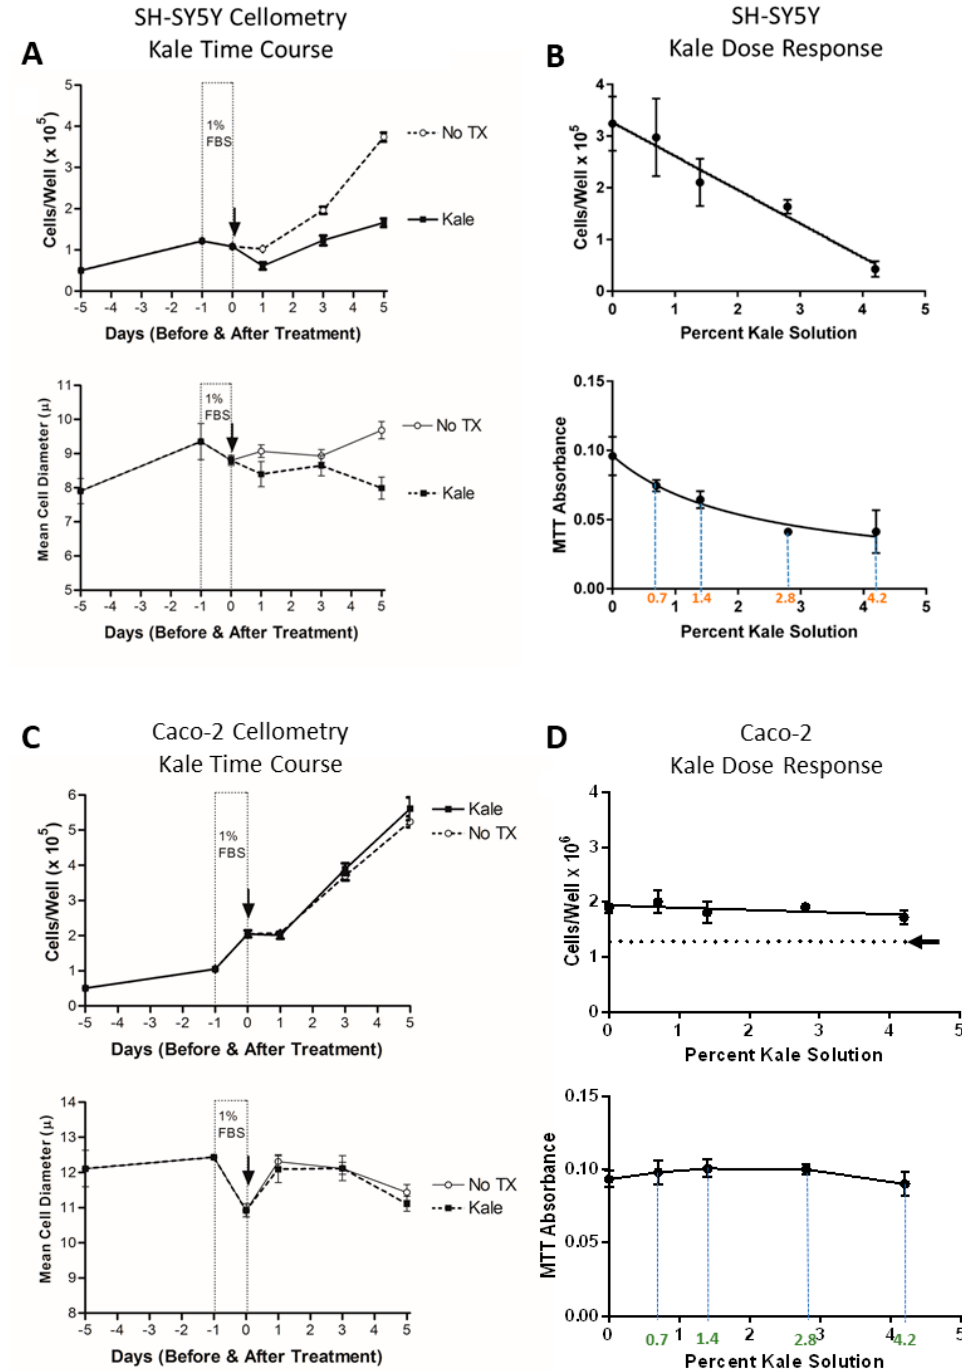
Figure 5. Kale juice time course and dose response curves for monocultures of SH-SY5Y ( A , B ) and Caco-2Bbe1 ( C , D ), comparing total cellometry counts, mean cell diameters, and MTT metabolism values. The same analytical methods were used as in Figure 4 except now in monocultures. After plating and growing the cells in 24-well plates for four days, they were switched to 1% FBS media for 24 h, and then given complete media replacements the next day with up to either 4.2% kale juice or 4.2% PBS and monitored over five more days: A-upper panel, SH-SY5Y cell counts; A-lower panel, SH-SY5Y mean cell diameters; C-upper panel, Caco-2Bbe1 cell counts, C-lower panel, Caco-2Bbe1 mean cell diameters. B-upper panel, SH-SY5Y cell counts; B-lower panel, SH-SY5Y MTT metabolism; D-upper panel, Caco-2Bbe1 cell counts, D-lower panel, Caco-2Bbe1 MTT metabolism. Arrows are shown to point the cell numbers present at day-0 of treatment (determined in adjacent wells). Points represent mean ± SEM ( n = 4 experiments per condition) and the curves were drawn in GraphPad Prizm.